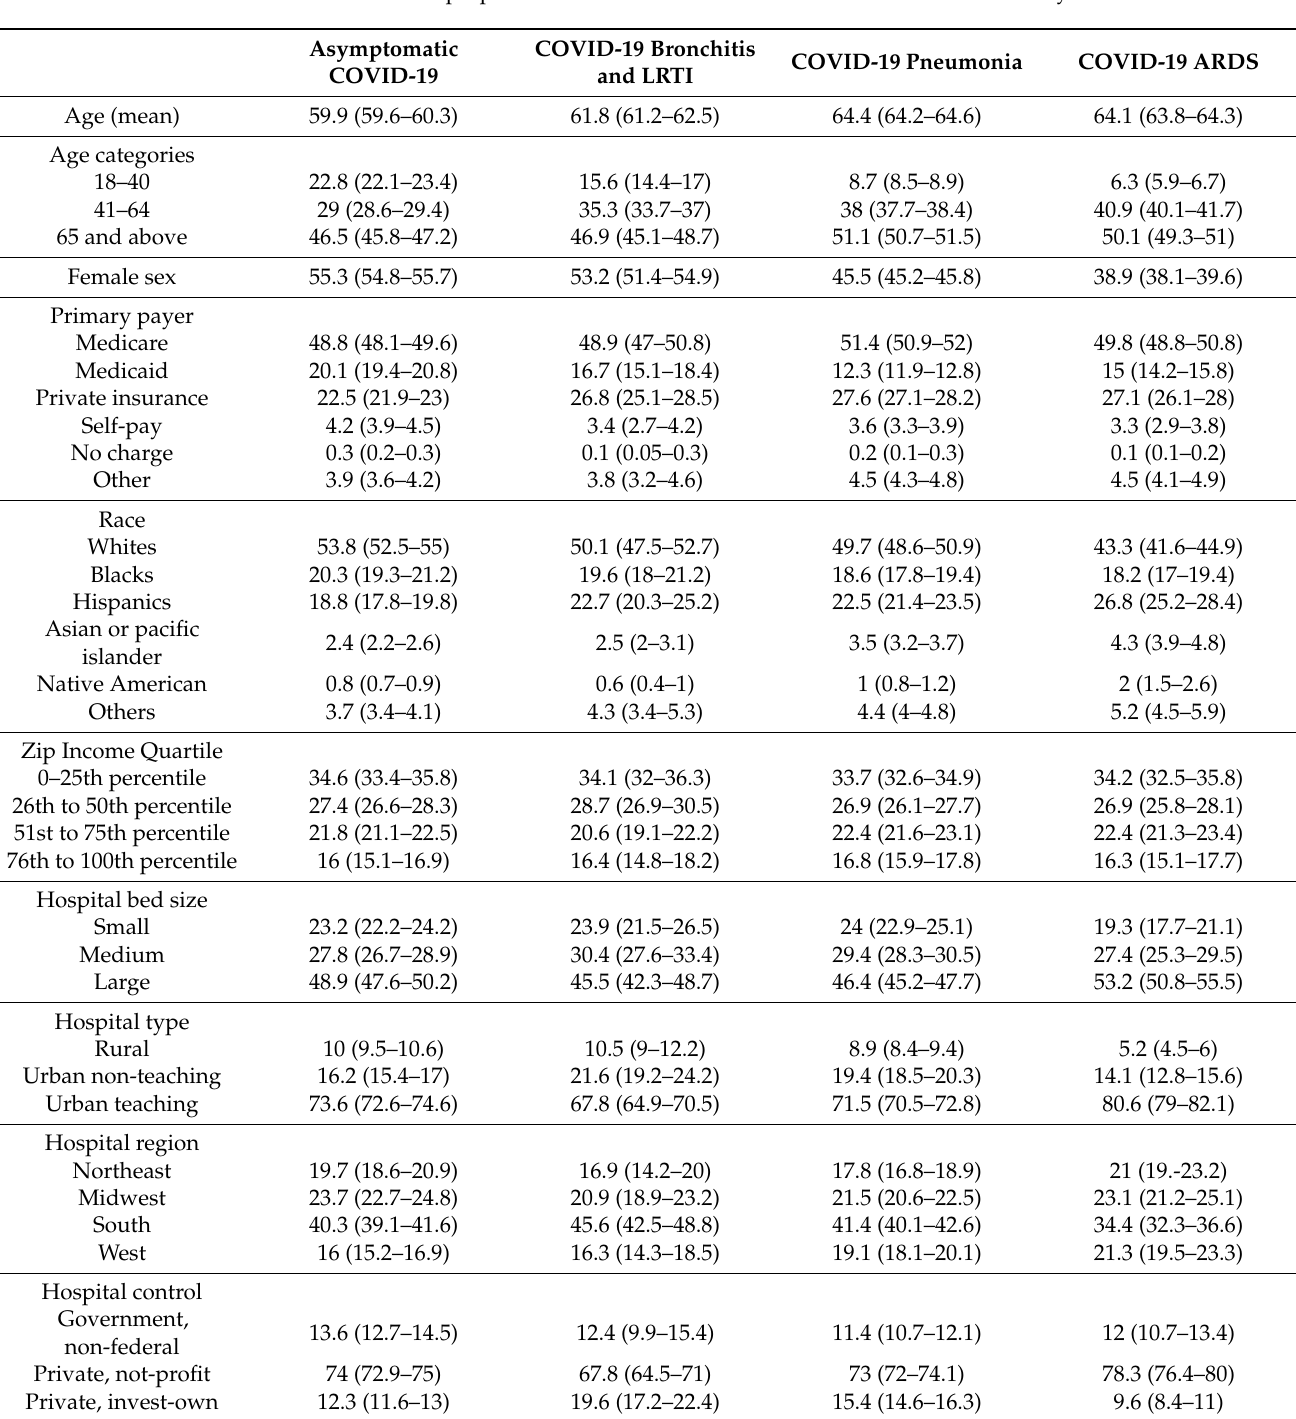
Table 1. The proportion of Socioeconomic Predictors for COVID-19